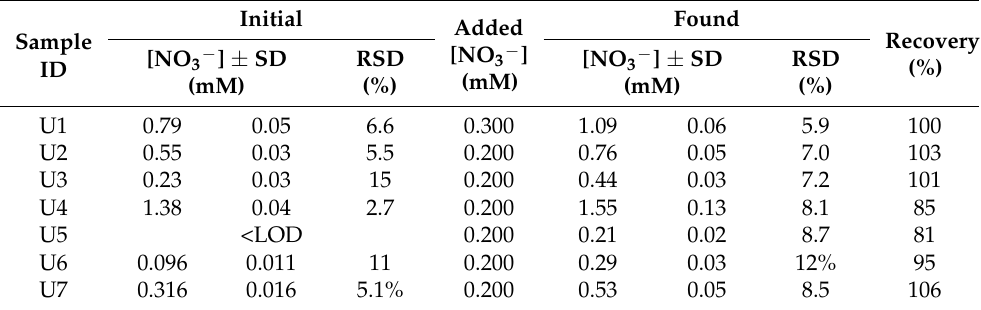
Table 4. Recovery percentages studies; standard deviation (SD); relative standard deviation (RSD).